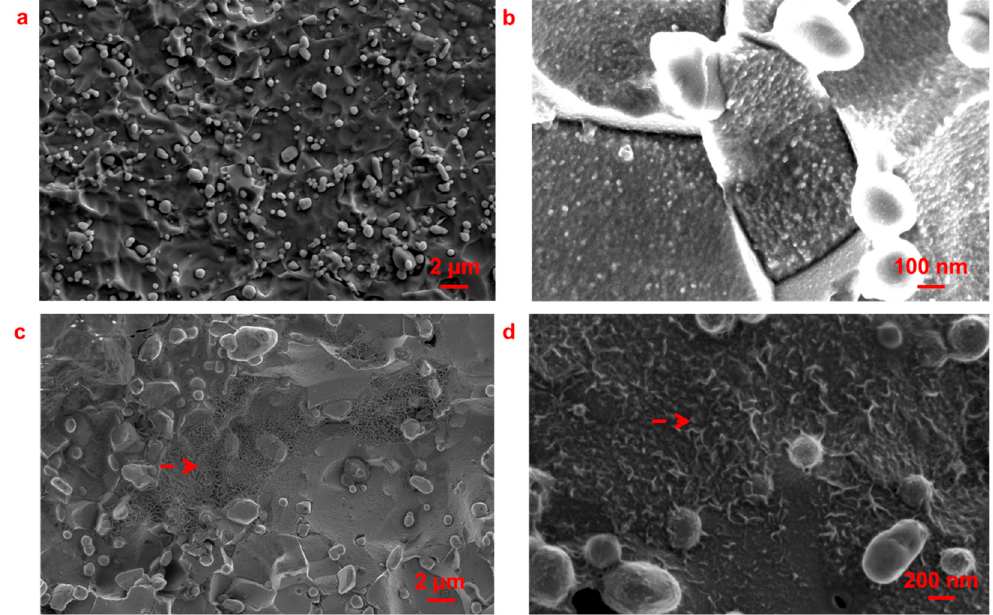
Figure 7. General corrosion on the BPE, with ( a ) carbides protruding out of the matrix, ( b ) grains with different heights and carbides at grain boundaries, and ( c, d ) the presence of